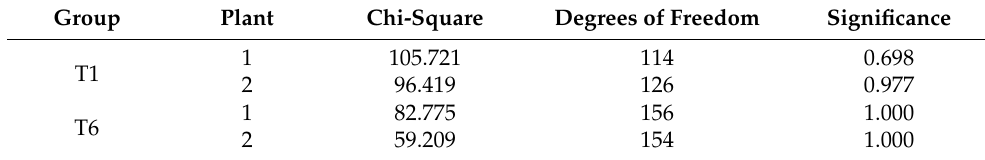
Table 3. The result of the test for Gaussian distribution of two plants in each group. Group Plant Chi-Square Degrees of Freedom